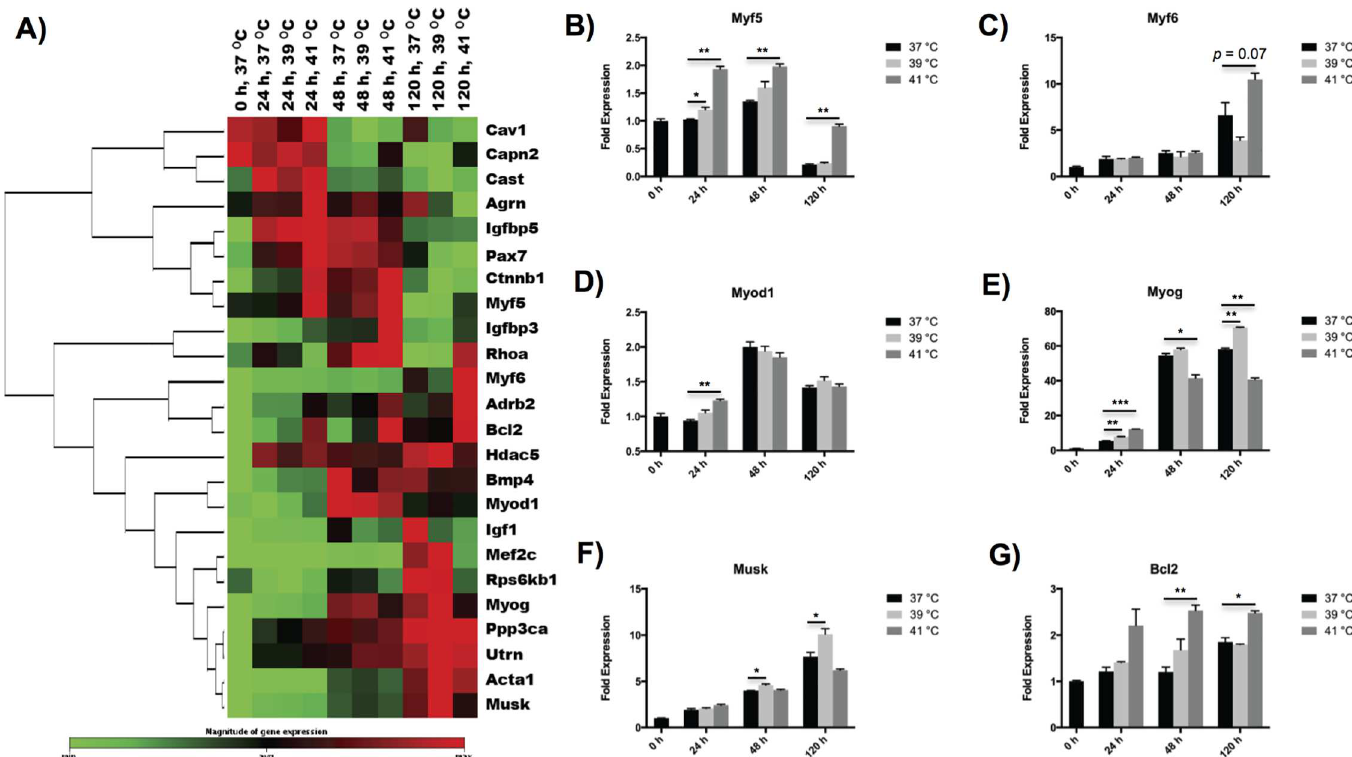
Fig 2. Effects of hyperthermia treatment on myogenesis of C2C12 myoblasts. (A) Clustergram of myogenesis genes showingtime- and temperature- dependences on hyperthermia treatment during myogenic differentiation. (B-G) Characteristic myogenesis genes representedin bar figures. The error bars in (B-G) represent the standard deviationof the mean, and the myotubes cultured at 37˚C were used as a control. All statistical differences against the control are indicated. * p < 0.05, ** p < 0.01, *** p < 0.001.